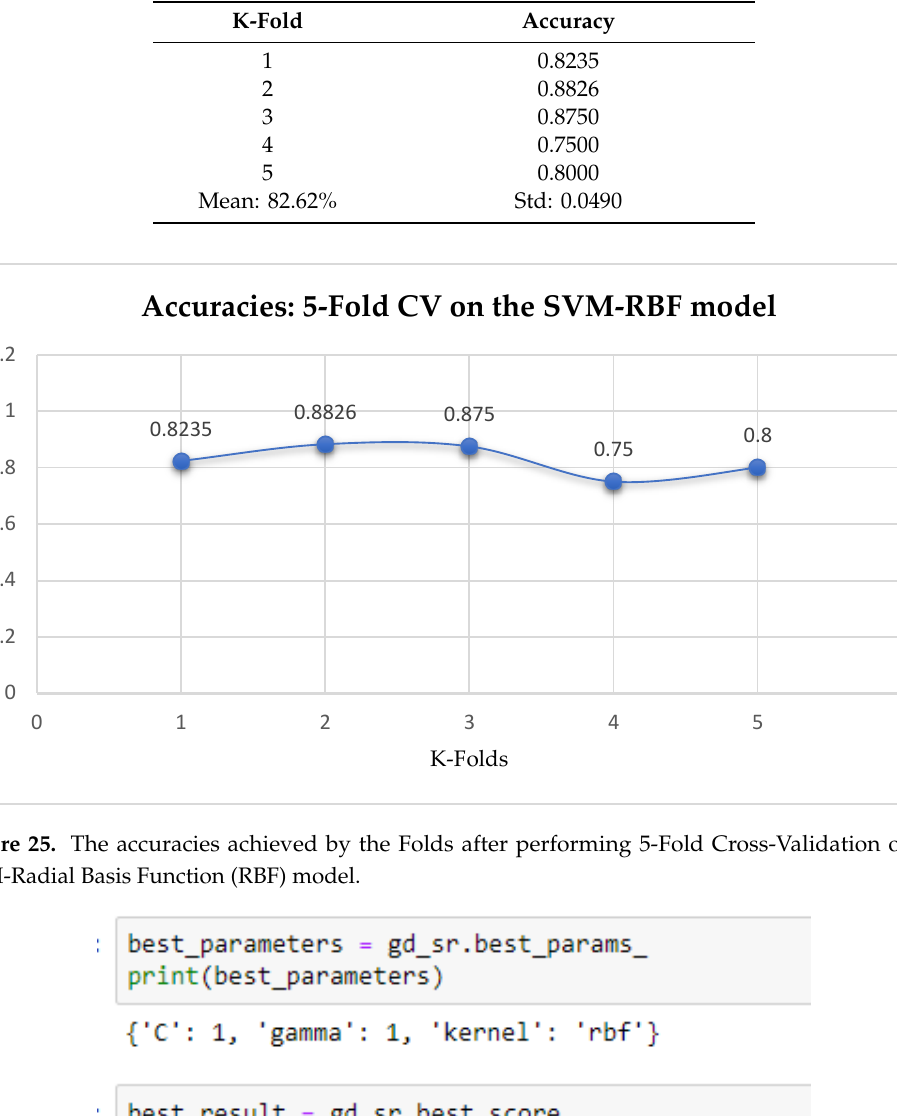
Table 7. Accuracies achieved by performing 5-Fold Cross-Validation on the SVM-RBF model.